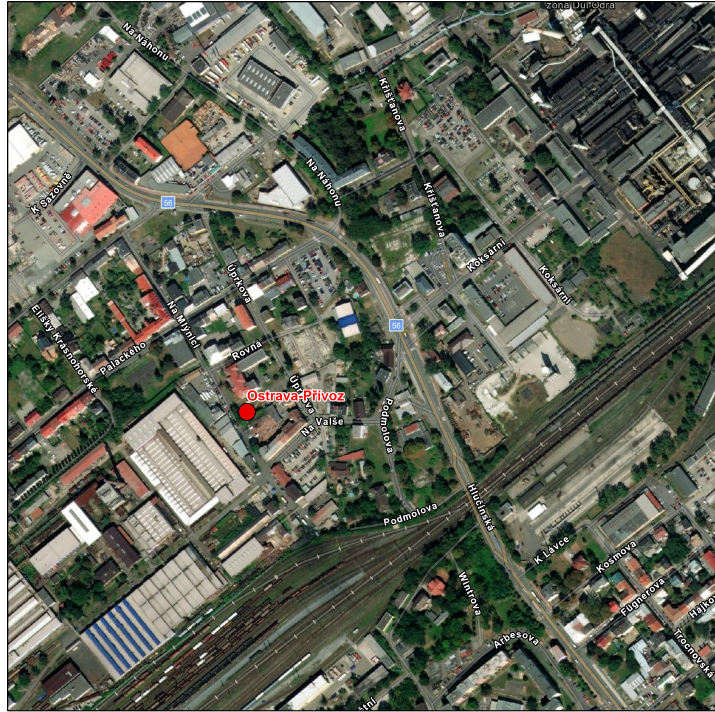
Figure A3. Location of the Ostrava-Pˇrívoz station.